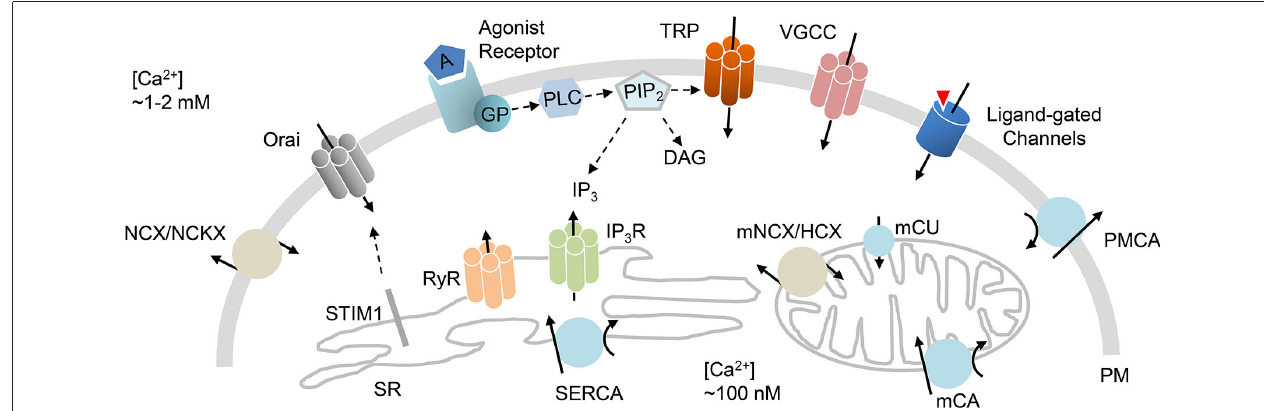
Release of Ca 2 + from the ER/SR is mediated through IP 3 (IP 3 R) or ryanodine (RyR) receptors. The reuptake of Ca 2 + into the ER/SR is primarily mediated by sarcoplasmic/ER Ca 2 + ATPase (SERCA). Mitochondrial Ca 2 + handling incorporates mitochondrial Ca 2 + uniporter (mCU), Ca 2 + ATPase (mCA) or Na + /Ca 2 + or H + /Ca 2 + exchangers (mNCX, mHCX). GP (G proteins); PIP 2 (phosphatidylinositol 4,5-bisphosphate); PLC (phospholipase